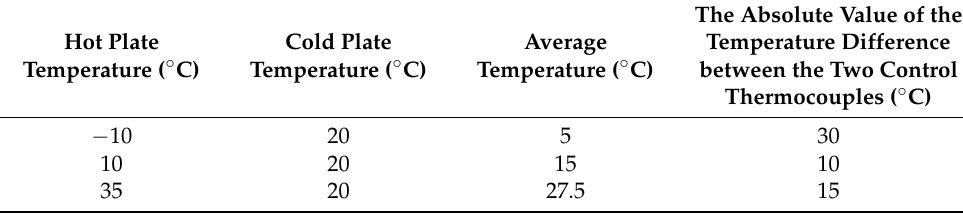
Table 2. The input data of HFM controller.